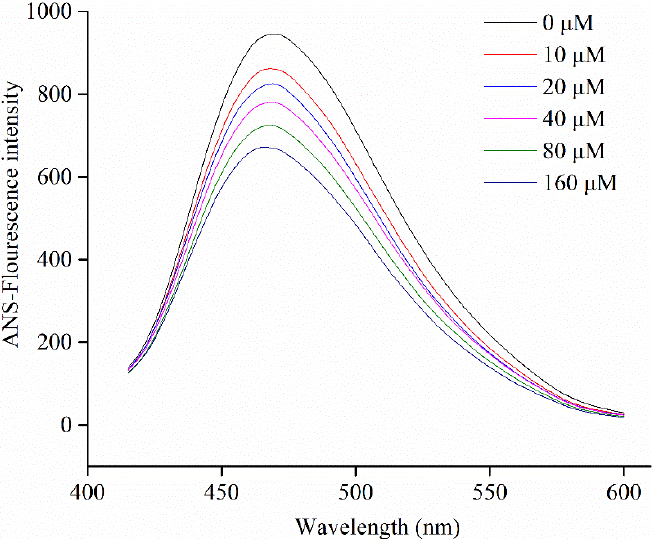
Figure 6. Changes in ANS ‐ fluorescence intensity of α‐ glucosidase at different concentrations of C3G.